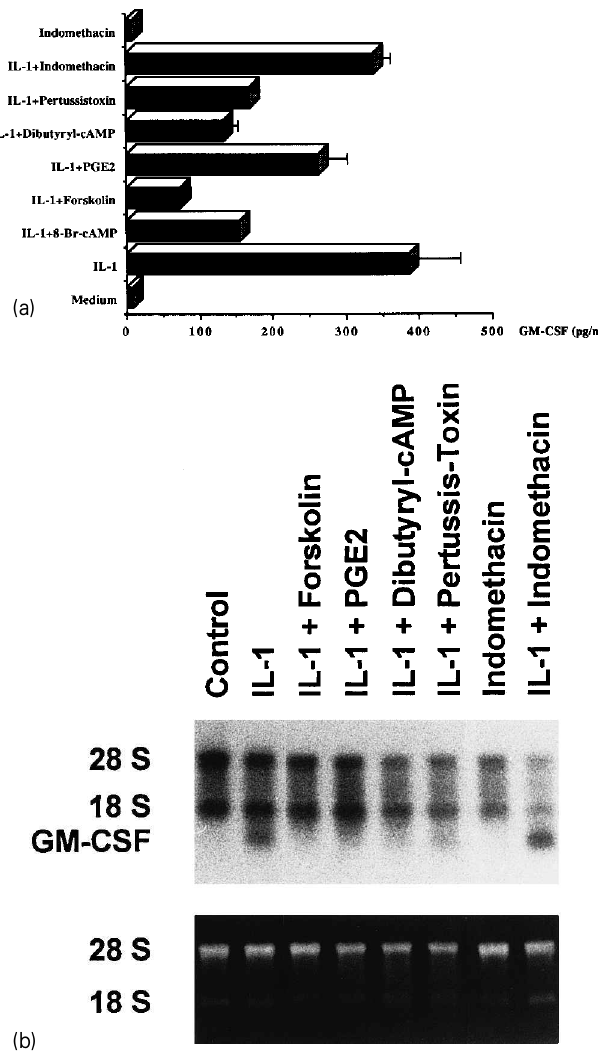
FIG. 4. Effect of different cAMP antagonists on the expression of GM-CSF by human stromal cells. Confluent secondary stromal cultures were incubated in medium alone or with the addition of the indicated stimuli. Concentrations used: IL-1 (100U/ml), forskolin (10 m M), PGE 2 (1 m M), dibuturyl-cAMP (1mM), pertussis toxin (1 m g/ml), indomethacin (10 m M). (A) After incubation for 24h, GM-CSF concentrations in the supernatants were assessed using a specific ELISA. GM-CSF levels are presented as deviation from maximal stimulation. Single experiments were carried out in triplicate, and data from three independent experiments are summarized as mean ± SEM. (B) After incubation for 6h total cellular RNA was prepared and subjected to Northern-blot analysis with cDNA probe for human GM-CSF. The 18 and 28S rRNA from ethidium bromide stained gel is shown as loading control. Data are representative for two experiments with stromal cells from